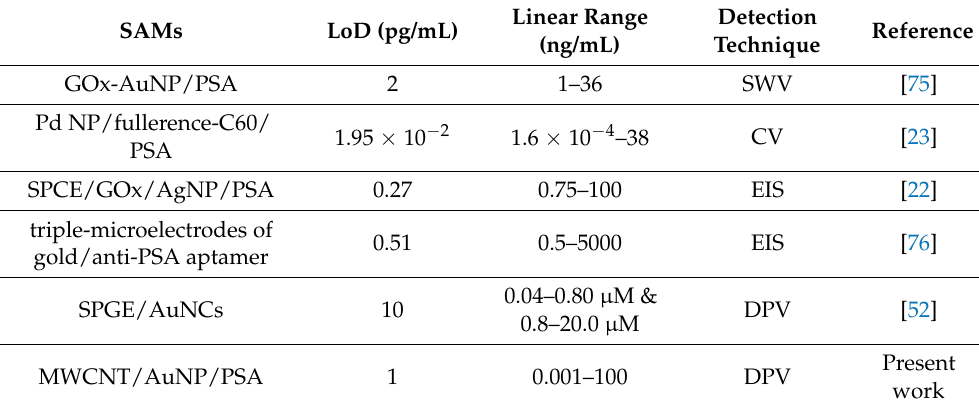
Table 2. Comparison of suggested PSA biosensors’ performance with other aptamer-based biosensors.